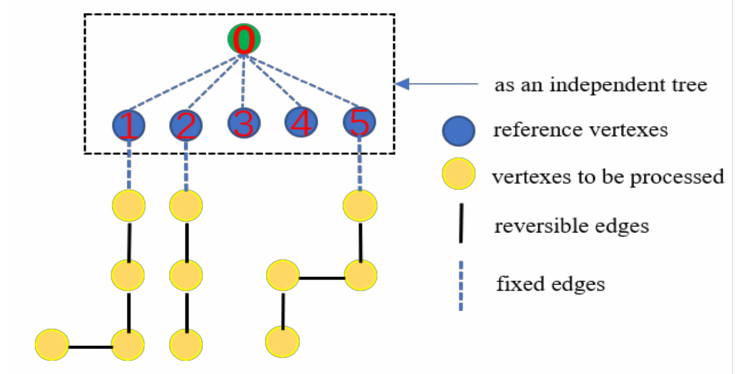
Figure 5. The improved minimum spanning